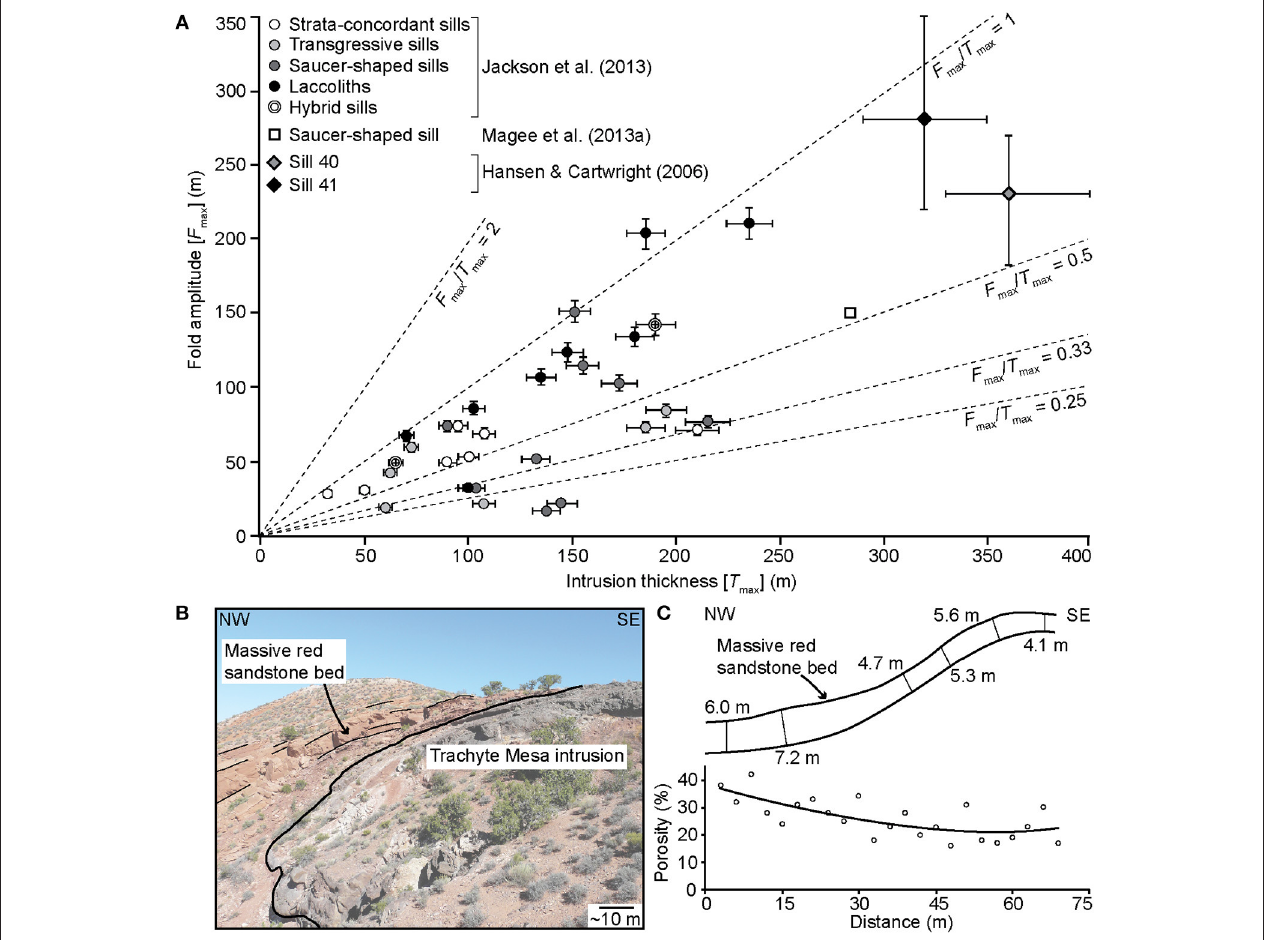
FIGURE 1 | (A) Seismically imaged maximum forced fold amplitudes ( F max ) plotted against maximum measured thicknesses ( T max ) of underlying sills or laccoliths from data within the: (i) Bight Basin, offshore southern Australia (Jackson et al., 2013); (ii) Exmouth Sub-basin, offshore north-western Australia (Magee et al., 2013a); and (iii) Rockall Basin, NE Atlantic ( Hansen and Cartwright, 2006). See Jackson et al. (2013) and Hansen and Cartwright (2006) for information on error bars. (B) Field photograph showing folding of sandstone beds above the Trachyte Mesa intrusion in the Henry Mountains, Utah, USA. (C) Sketch showing changes in thickness of a massive red sandstone bed, shown in (B) , over the Trachyte Mesa intrusion, which corresponds to a reduction in porosity (after Morgan et al., 2008). The best-fit curve is third order polynomial with an R 2 value of 0.49 ( Morgan et al., 2008).